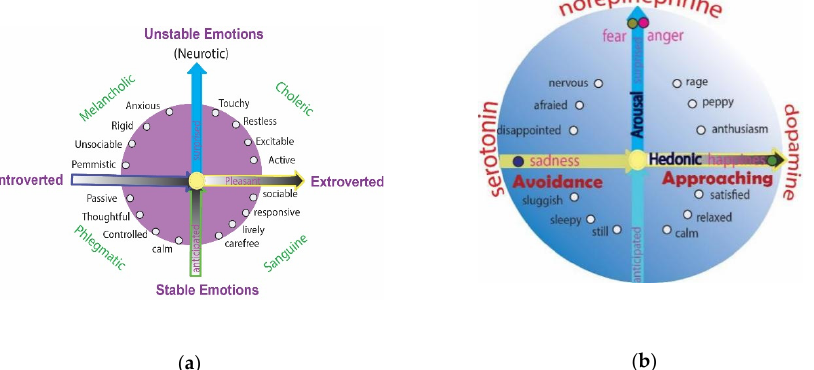
Figure 1. Similarity between Eysenck's dimension and emotional dimensions. ( a ) Eysenck described two factors to account for variations in our personalities: extroversion/introversion and emotional stability/instability [34]. ( b ) Dimensional theories about emotions and basic emotions with monoamine neurotransmitters [38].